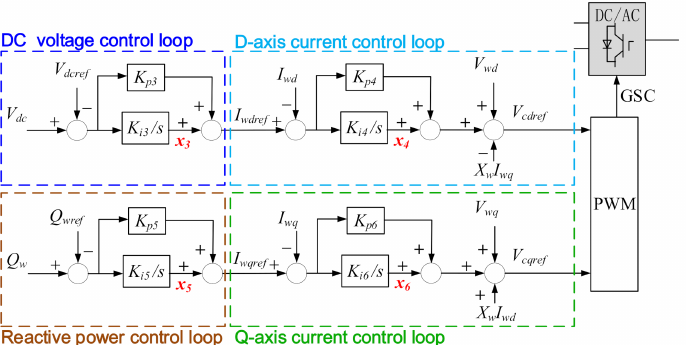
Figure 5. Control structure of GSC in